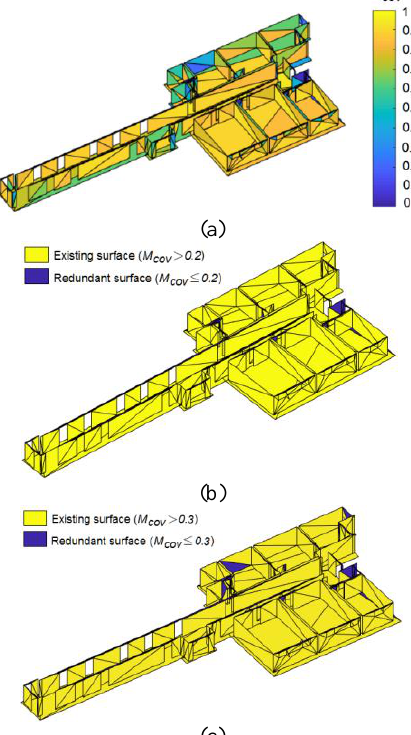
Figure 7. Comparison results of the TUB1 of the ISPRS benchmark dataset: (a) the BIM with surfaces colorized according to the coverage 𝑀 𝑐𝑜𝑣 ; (b) and (c) the BIM with the location of redundant elements (blue) and existing surfaces (yellow) with 𝑀 𝑐𝑜𝑣 ≈ 0.2 and 𝑀 𝑐𝑜𝑣 ≈ 0.3 ,